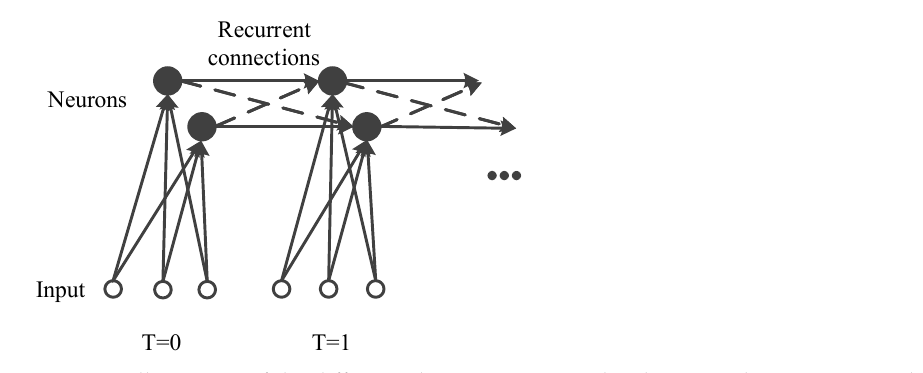
Figure 1. Illustration of the difference between RNN and IndRNN. IndRNN removes the crossed recurrent connections among neurons (in dotted lines) to simplify the recurrent computation and, thus, the gradient